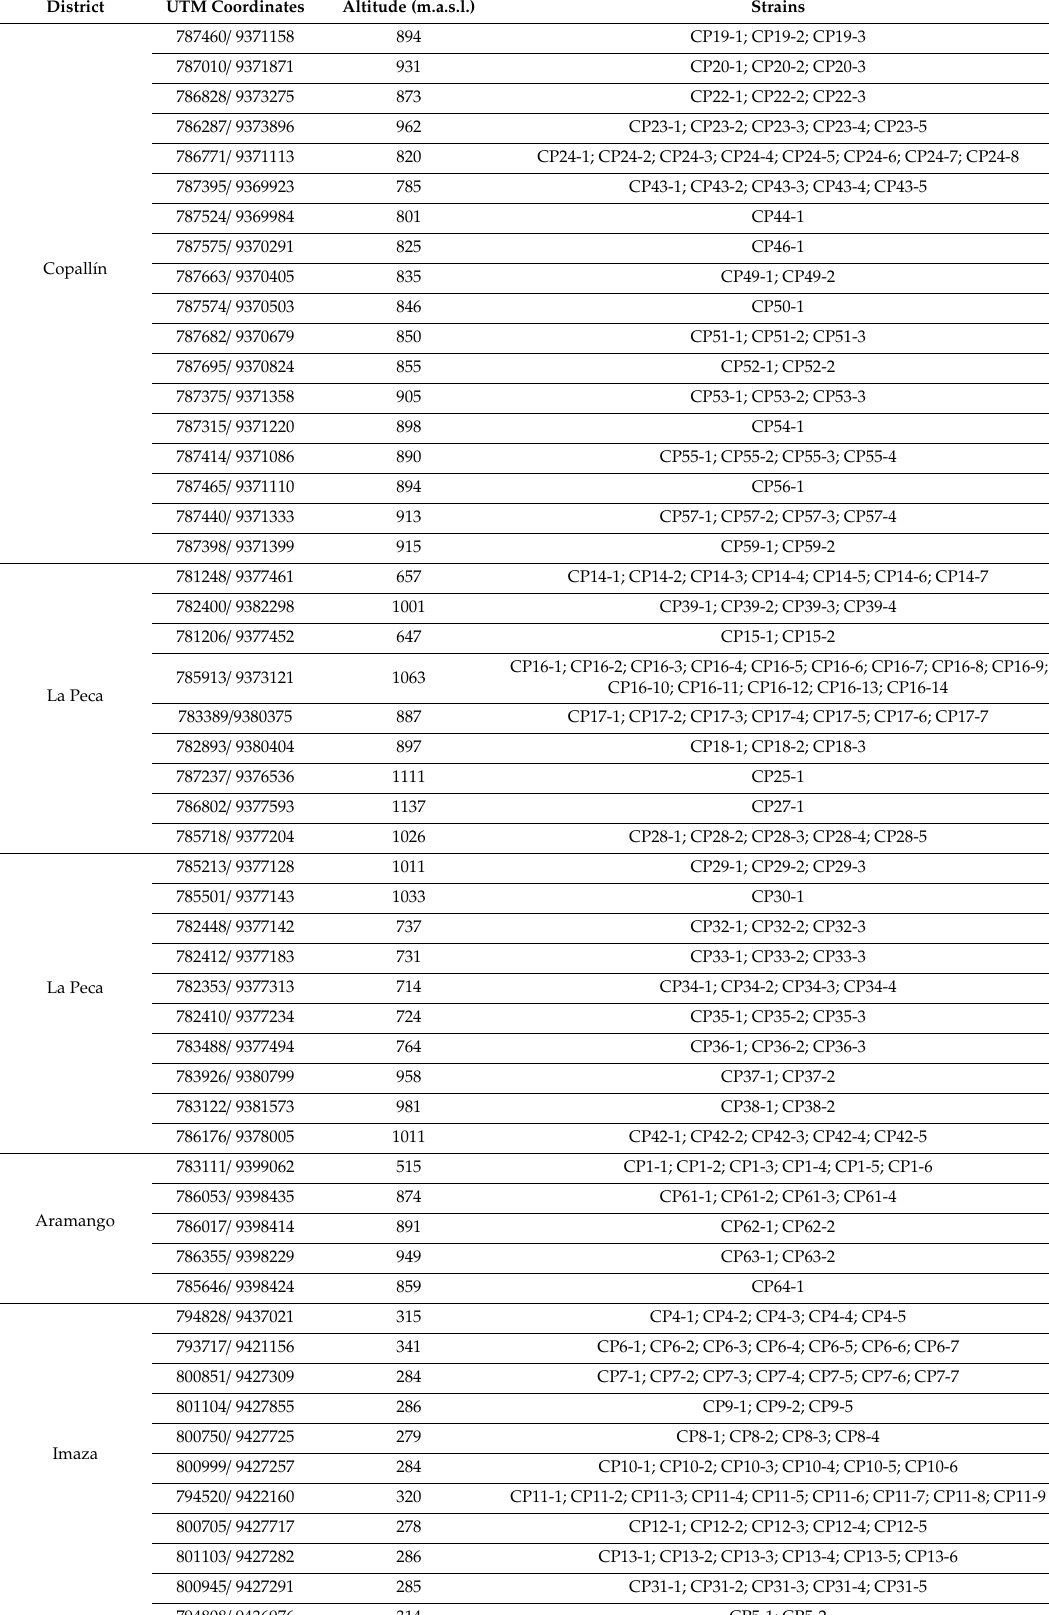
Table 1. Native Trichoderma spp. strains from soils of the province of Bagua, evaluated in vitro against Moniliophthora roreri , the causal agent of frosty pod rot in Peru. District UTM Coordinates Altitude (m.a.s.l.)